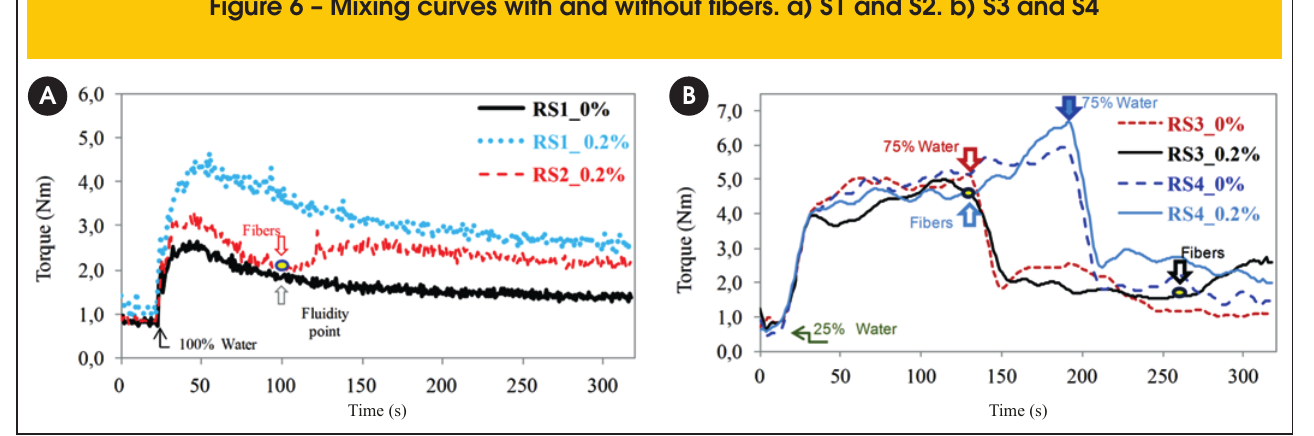
Figure 6 – Mixing curves with and without fibers. a) S1 and S2. b) S3 and